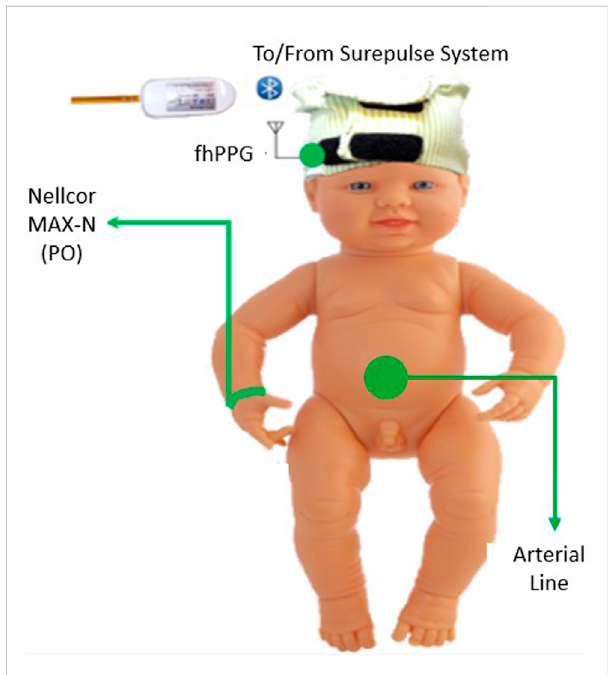
FIGURE 1 Diagramoftheplacementoftheequipmentonthesubjectinthe trial. The Nellcor PO was placed on the right wrist and the fhPPG on the